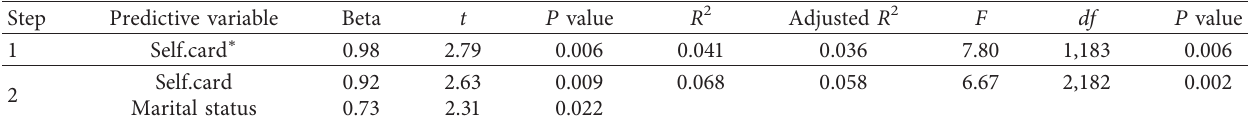
Table 4: Factors affecting nurses’ attitude regarding organ donation.